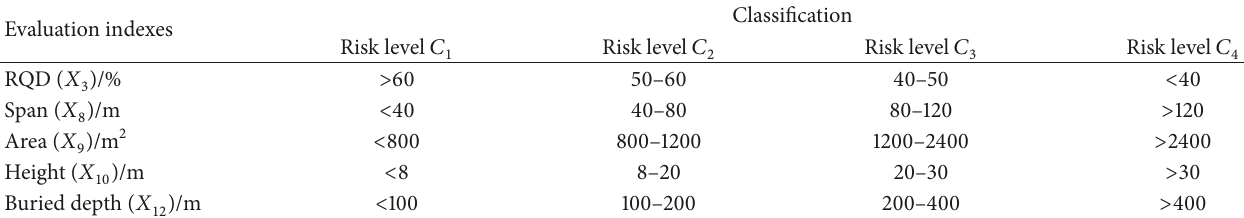
Table 2: Classification criteria for evaluation of risk levels with quantitative